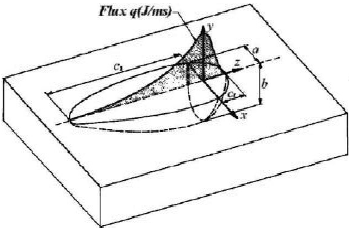
Figure 3 Double ellipsoid heat source model During the simulation, some parameters of the heat source are given. The given heat source parameters are shown in Table